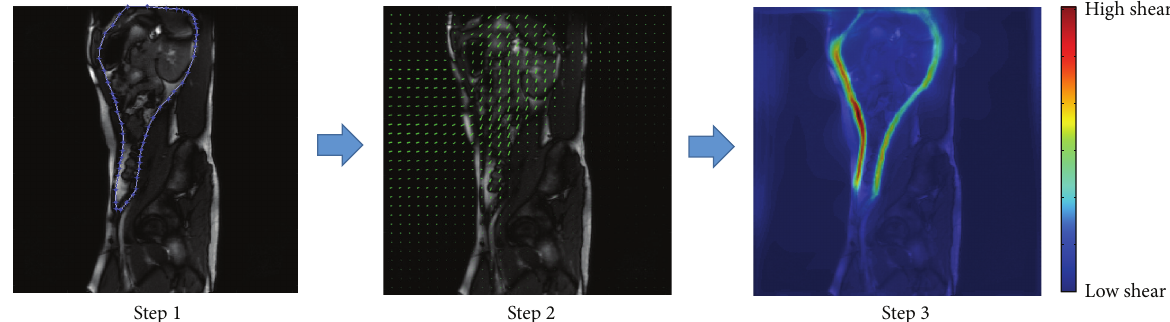
Figure 2: Flow chart describing the methodology. Step 1: typical region drawn to separate (segment) the two regions of different motion; step 2: depiction of the mathematically quantified movement; step 3: depiction of the shear taking place along the boundary in a “sheargram”.